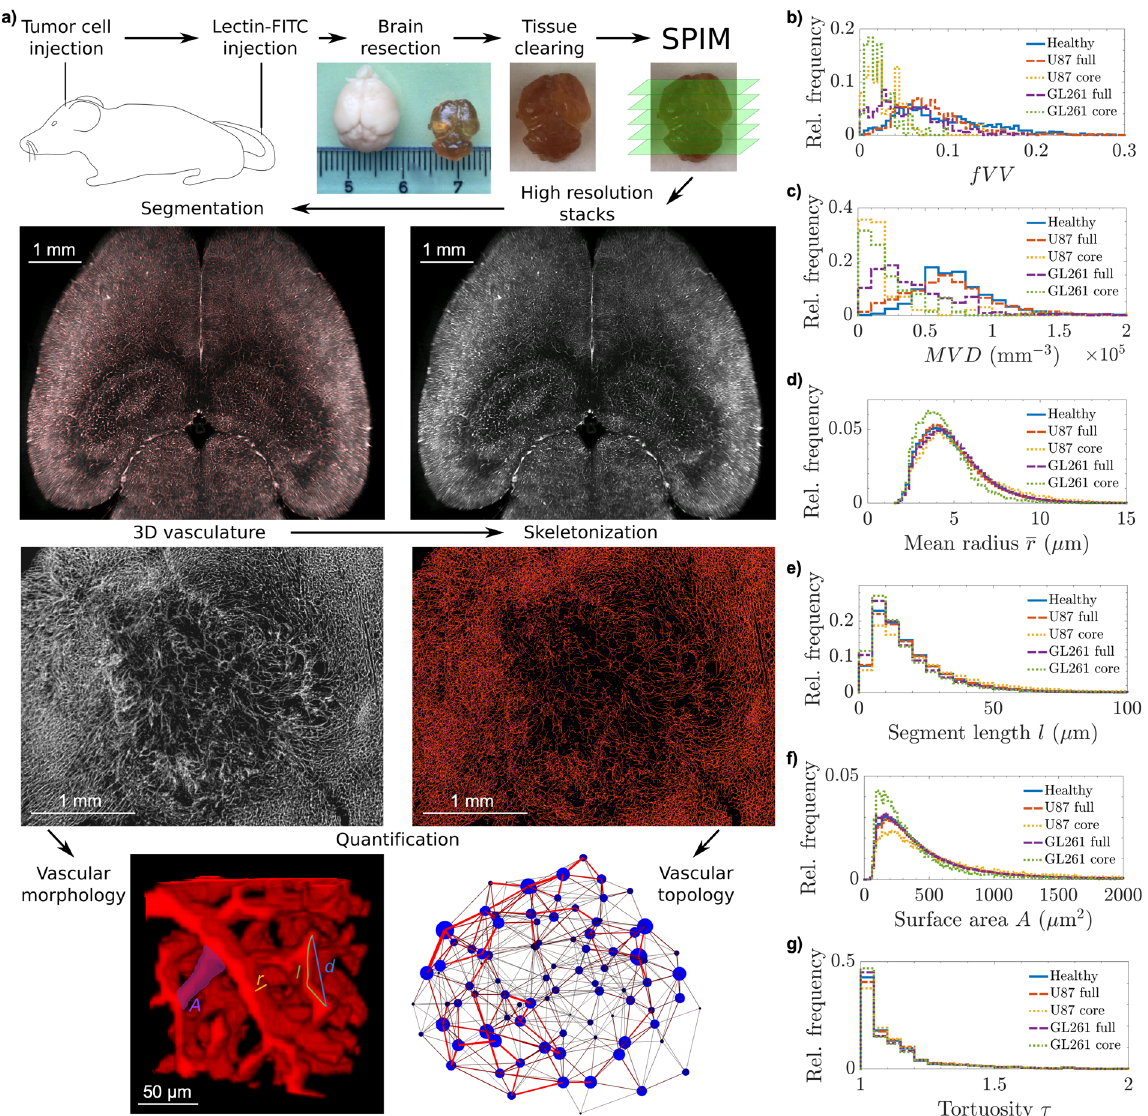
Figure 1. Data acquisition and processing with geometric quantifications. ( a ) Schematic illustration of experimental procedures, including tumor cell and fluorescent marker injections, brain resection and clearing, with photographs of uncleared and cleared brains with cm scale, and Selective Plane Illumination Microscropy (SPIM). In the second row, an original image from a stack of a healthy mouse brain is presented on the right, with the binary segmentation overlay in red to the left (see Supplementary Movies 1, 2 and 3 for segmentation results in more detail). Below the brain segmentation image, an average intensity projection from a 200 μ m thick section of a segmented, noise-filtered, and hole-filled image stack of a U87 glioblastoma is shown. To the right, the skeletonized version of the same dataset is presented, with branch voxels in orange and branching points in magenta. The vascular network quantifications on this post-processed data are illustrated in the last row. The vascular morphology assessment is clarified in a cube of 130 μ m side length, marking a radius value r , length l and endpoint-separation d , as well as a segment’s surface area A . Using the vascular skeleton, the network topology is studied, which is illustrated by a clustered graph, presenting the spatial distribution of vessel communities in a U87 glioblastoma. From the geometric quantifications, relative frequency distributions of ( b ) fractional vessel volume fVV and ( c ) microvascular density MVD in cubes with 500 μ m side length, and distributions of geometric characteristics of all individual vessel segments are presented: ( d ) mean vessel radius r , ( e ) segment length l , ( f ) surface area A , and ( g ) segment tortuosity τ